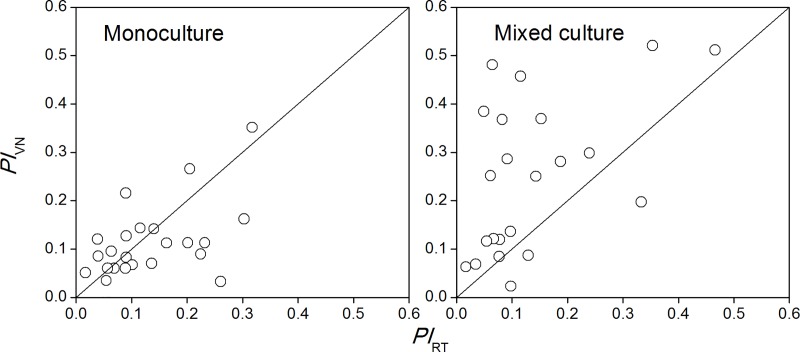
Trait plasticity index of Rhus typhina (PIRT) and Vitex negundo var. heterophylla (PIVN) in monoculture and mixed culture.